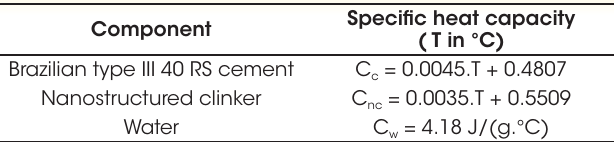
Specific heat capacity of each component of the cement paste